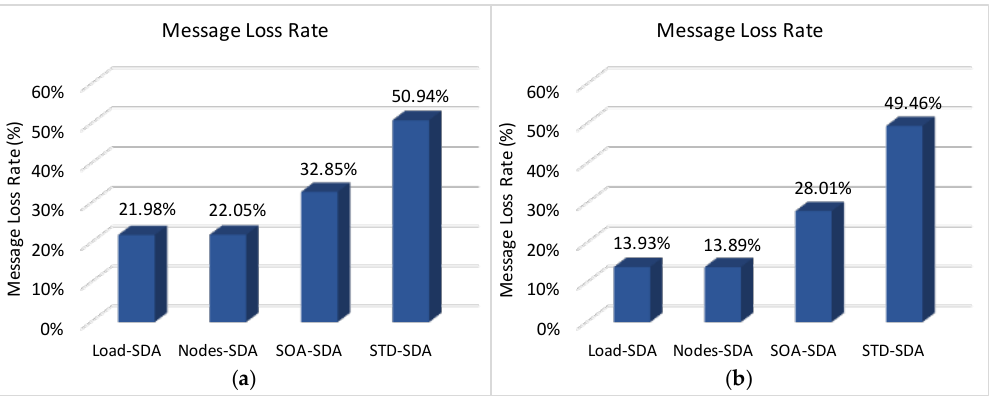
Figure 17. Message loss rate for the SDA schemes: ( a ) Unconditioned Scenario; ( b ) Conditioned